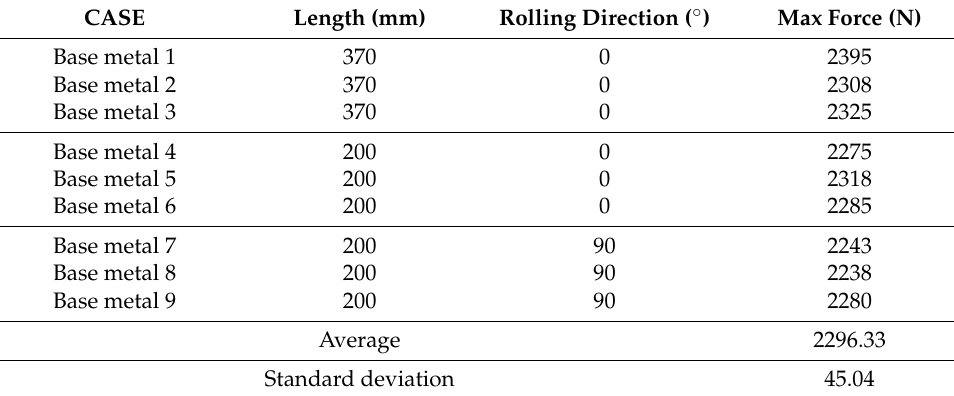
Table 10. Base material shear strength test